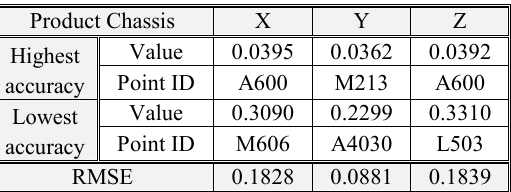
Table 5. Accuracy of points considering RMSE in produced chassis.